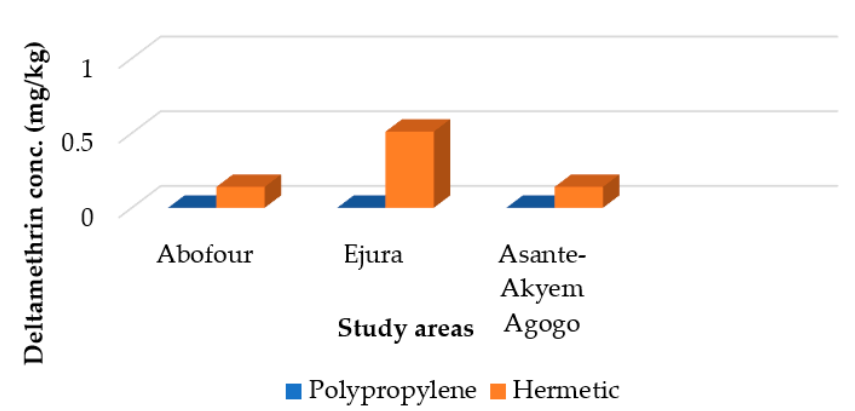
Figure 3. Deltamethrin residue in hermetic and polypropylene bags among study locations.